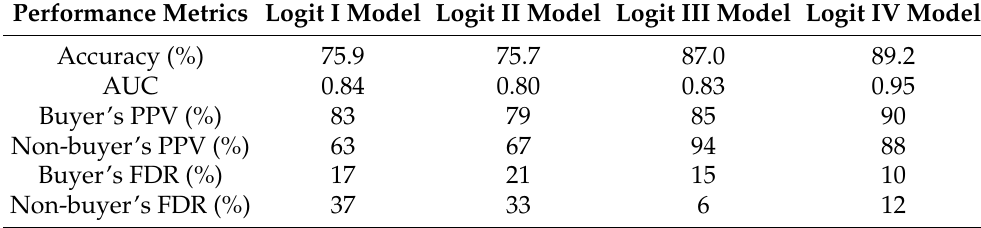
Table 10. Performance analysis of all logit